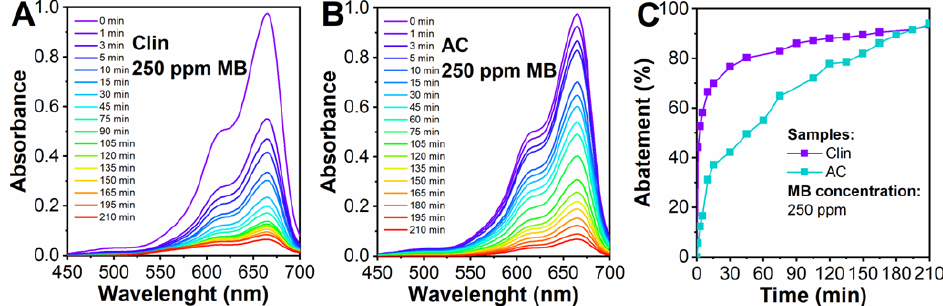
Figure 5. Clin (5 g L − 1 ) abatement tests ( A ) and AC (5 g L − 1 ) ( B ) were performed with 250 ppm MB. MB abatement as a function of time ( C ) at 250 ppm MB.